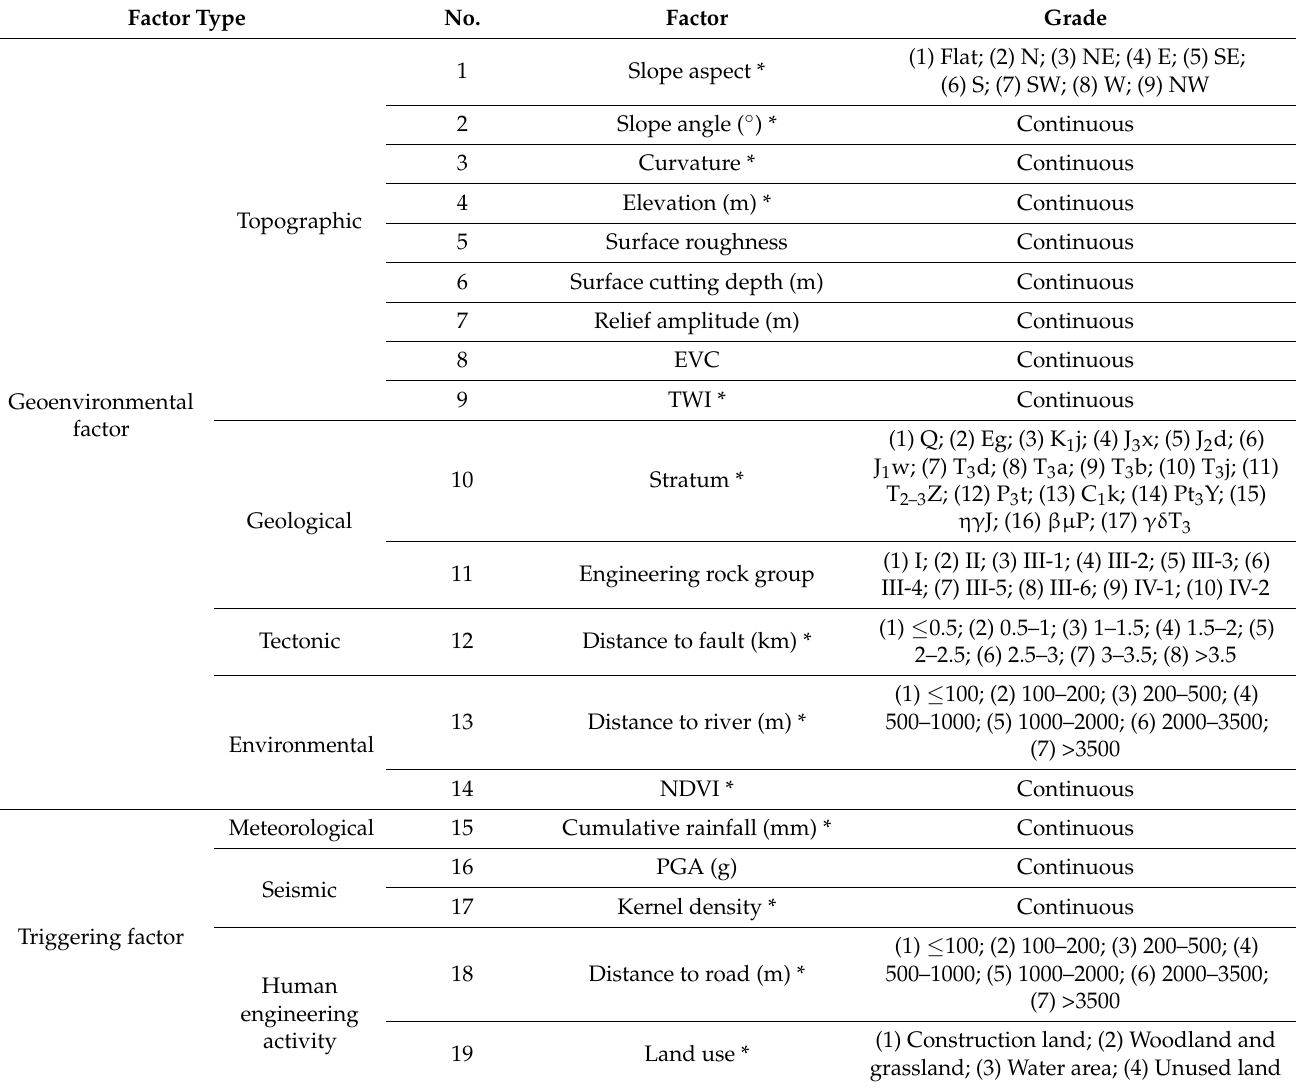
Table 2. Geoenvironmental and disaster-inducing factors of landslides in the study